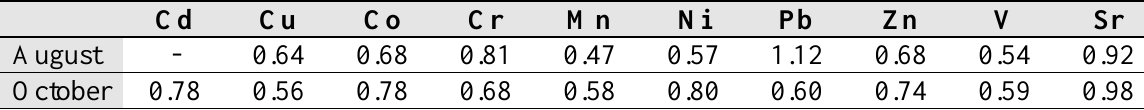
Table 4. - The average seasonal values of translocation ability (TA)